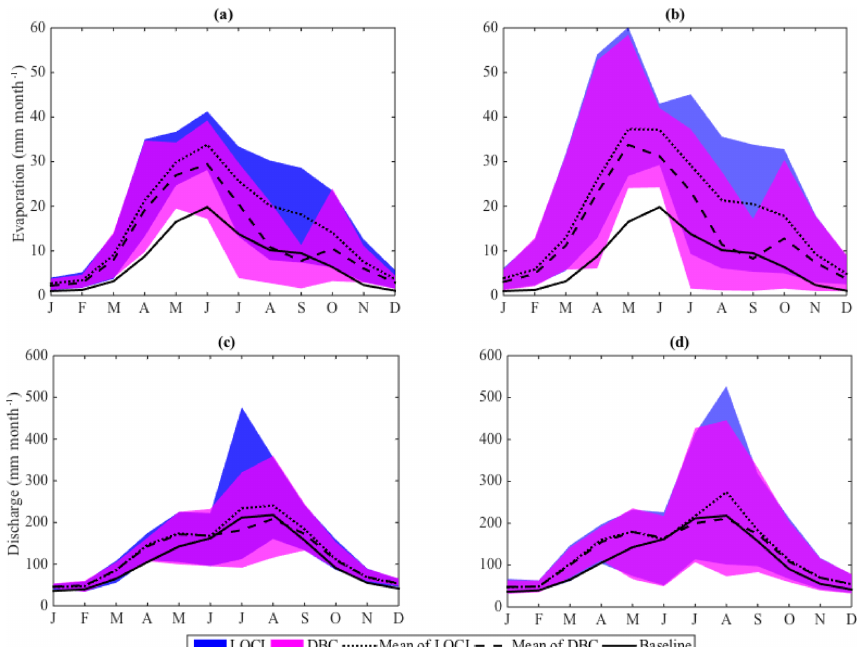
Figure 14. Projected monthly averages of evaporation and total discharges for 2046–2065 (a, c) and 2080–2099 (b, d) . Projections are shown from the two bias-correction methods (LOCI and DBC) with two ensembles of four GCMs under RCP4.5 and RCP8.5 (Table 2). (a) Monthly averages of evaporation at the middle of the century (2046–2065); (b) monthly averages of evaporation at the end of the century (2080–2099); (c) monthly averages of discharge at the middle of the century (2046–2065); (d) monthly averages of discharge at the end of the century (2080–2099). Shading denotes the ensemble range of projections by LOCI (blue) and DBC